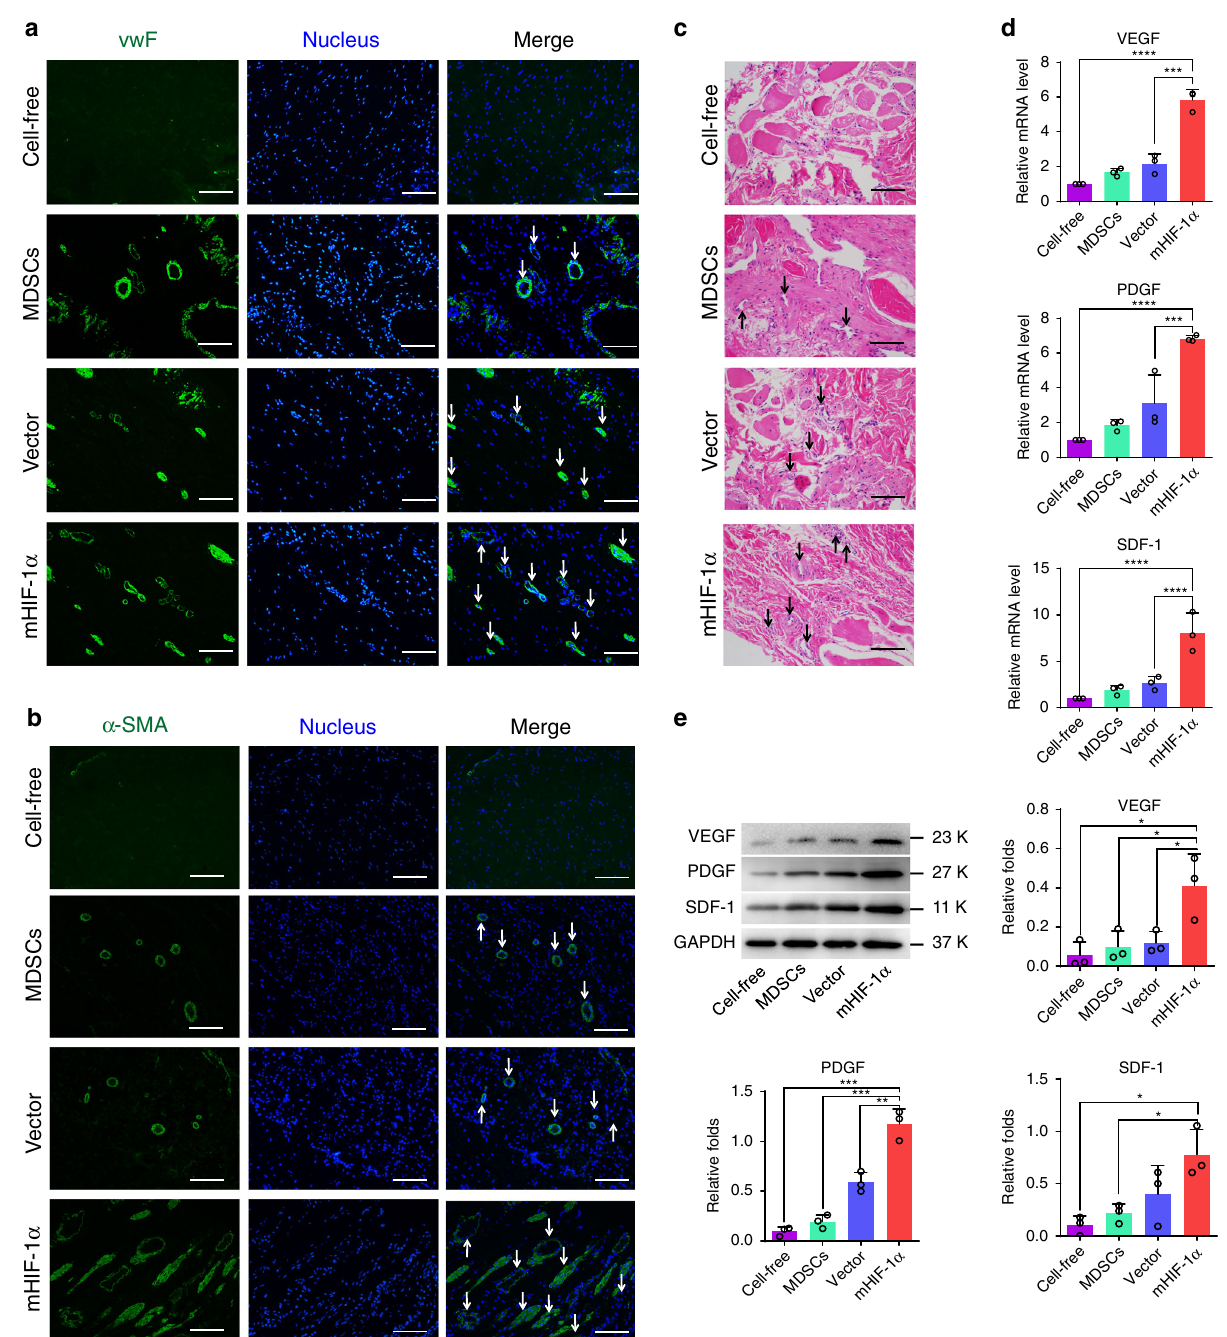
Fig. 5 Histological and molecular biological analysis of repaired corpus cavernosa. a Immuno fl uorescence images of repaired corpus cavernosum showing that the ECs were positive for vWF (green) and cell nuclei (DAPI, blue) after 4 months of implantation ( n = 3). (scale bar, 100 μ m). b Immuno fl uorescence images of repaired corpus cavernosa showing that the SMCs were positive for α -SMA (green) and cell nuclei (DAPI, blue) after 4 months of implantation ( n = 3). (scale bar, 100 μ m). c H&E staining images of repaired corpus cavernosa in the cell-free, MDSCs, vector and mHIF-1 α groups after 4 months of implantation ( n = 3). (scale bar, 100 μ m) (d) Comparative gene expression analysis of VEGF, SDF-1 and PDGF via the qRT-PCR assay for the cell-free, MDSCs, vector and mHIF-1 α groups after 4 months of implantation ( n = 3). (Sidak's multiple comparisons test, two-way ANOVA. In d all the *** p = 0.0001, **** p <0.0001). e Protein expression of VEGF, SDF-1 and PDGF via WB detection in the cell-free, MDSCs, vector and mHIF-1 α groups after 4 months of implantation ( n = 3). (Sidak's multiple comparisons test, two-way ANOVA. In e , VEGF, mHIF-1 α vs cell-free * p = 0.0246, mHIF-1 α vs MDSCs * p = 0.0397, mHIF-1 α vs Vector * p = 0.0416; In e , PDGF, mHIF-1 α vs cell-free *** p = 0.0003, mHIF-1 α vs MDSCs *** p = 0.0005, ** p = 0.0050; In e , SDF1, mHIF-1 α vs cell-free * p = 0.0104, mHIF- 1 α vs MDSCs * p = 0.0192). All arrows in a – c indicate the blood vessels. Data are displayed as